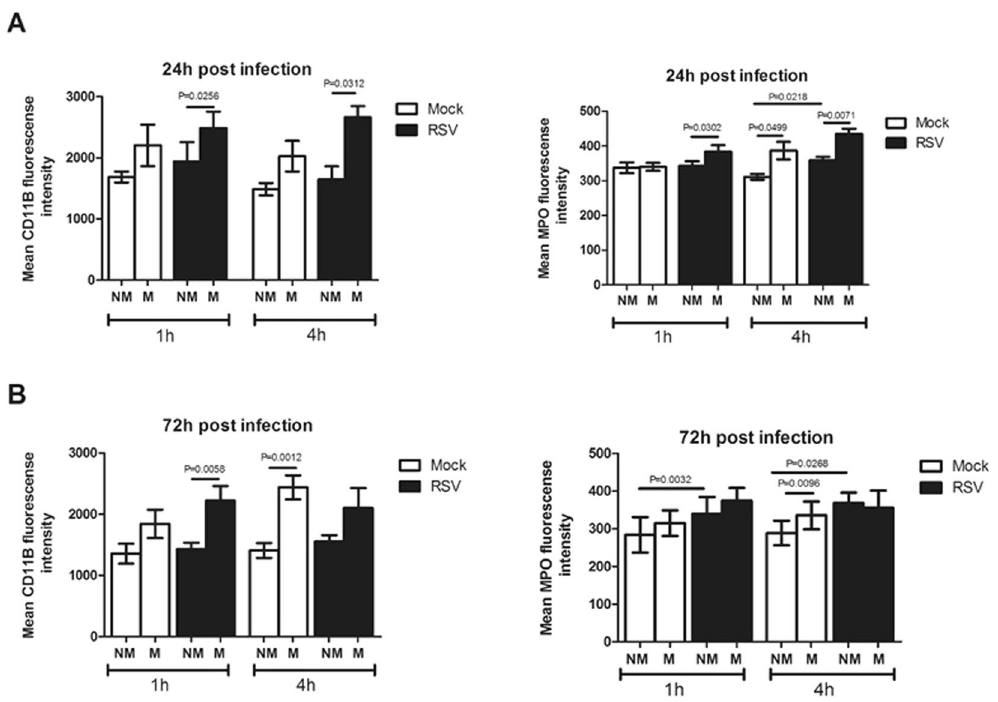
Figure 5. Migrated neutrophils show increased cell surface expression of CD11B and MPO compared to non-migrated neutrophils. Neutrophils that migrated (M) to the apical compartment through RSV infected epithelial cells infected for (A) 24 hours or (B) 72 hours showed higher cell surface expression of i) CD11B and ii) MPO compared to those non-migrated (NM) neutrophils that remain on the basolateral side. The percentage of migrated and non-migrated neutrophils expressing CD11B and MPO was calculated by staining for cell surface expression of CD11B (PE) and MPO (APC) were determined by flow cytometry. Neutrophils were gated on initially using a PE positive gate. Using this population the geometric mean fluorescence intensity of PE and APC fluorescence was calculated. Bars show mean ± SEM of n = 4 biological repeats. Statistical significance is shown. For all other comparisons P >